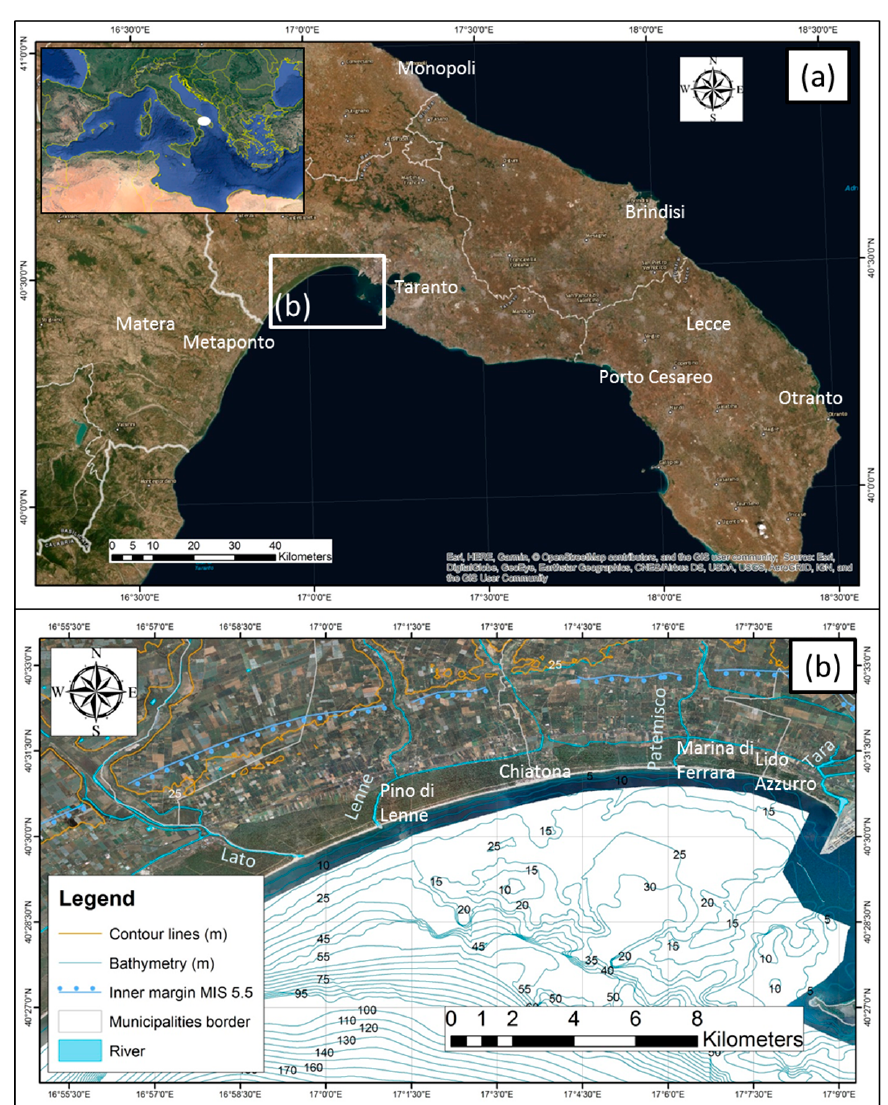
Figure 2. The study area of the Apulia region (Southern Italy): ( a ) the coastal plain of the Gulf of Taranto, Northeastern to Southwestern trending, highlighted by the white box and ( b ) the coastal stretch extending between Castellaneta and Taranto.